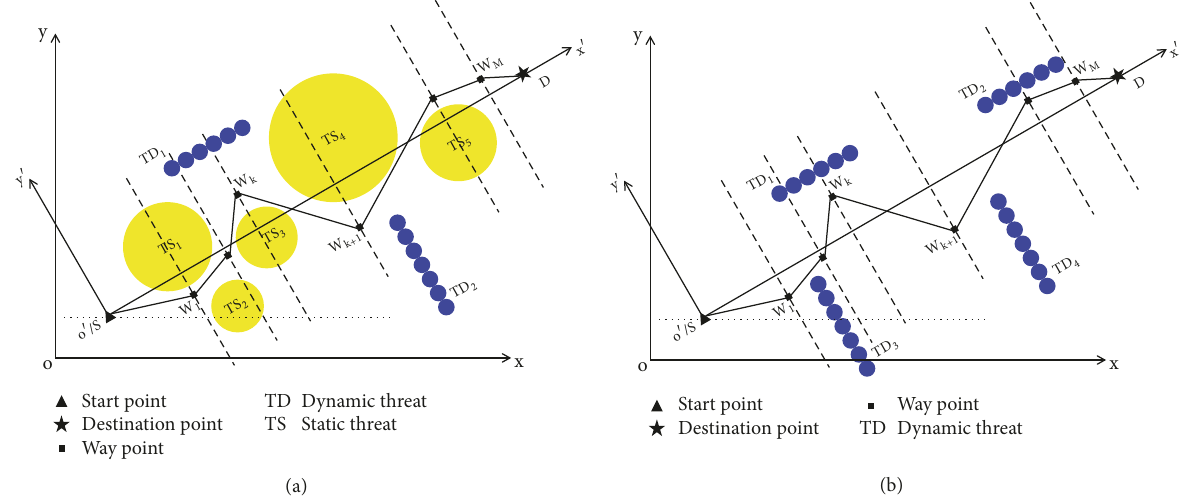
Figure 2: Transformation of coordinate system in UAV path planning model. (a) contains both mobile threats and static threats while (b) only contains mobile